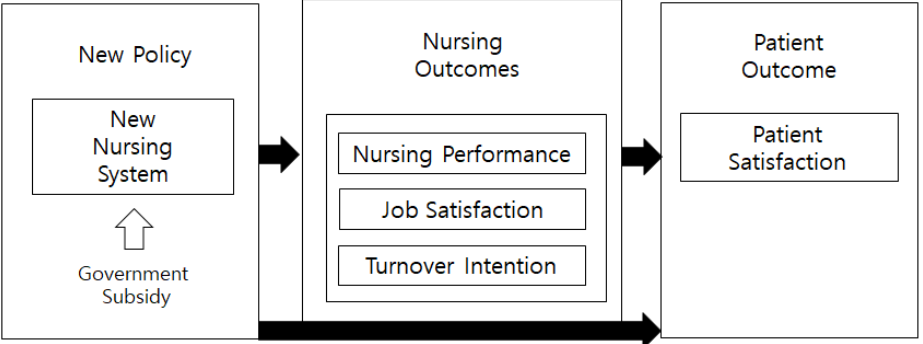
Figure 1. Conceptual framework of this study.